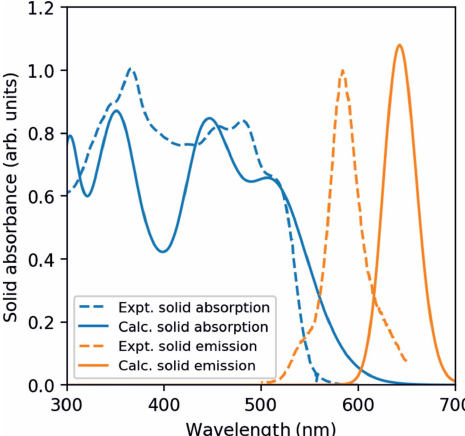
Figure 12 Comparison of the calculated spectra of the TAAP crystal in the Clausius–Mossotti approximation with the experimental